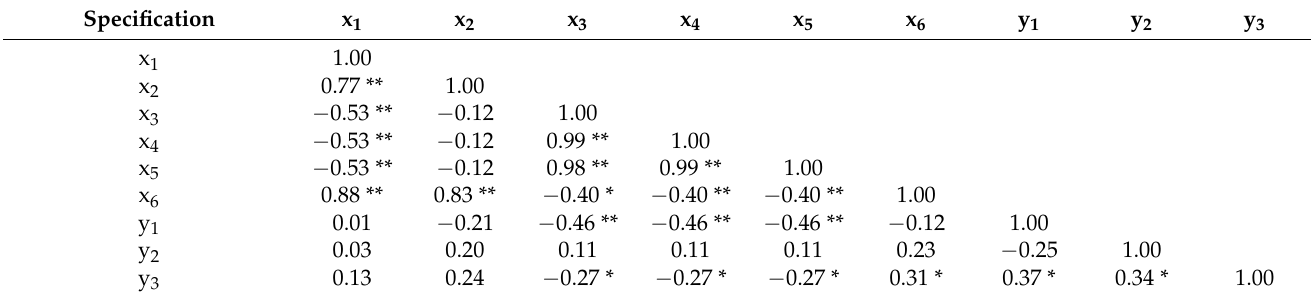
Table 14. Pearson’s simple correlation